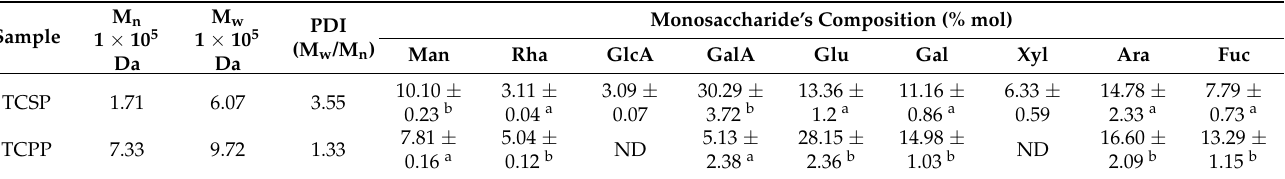
Table 2. Molecular weight and monosaccharide composition of TCSP and